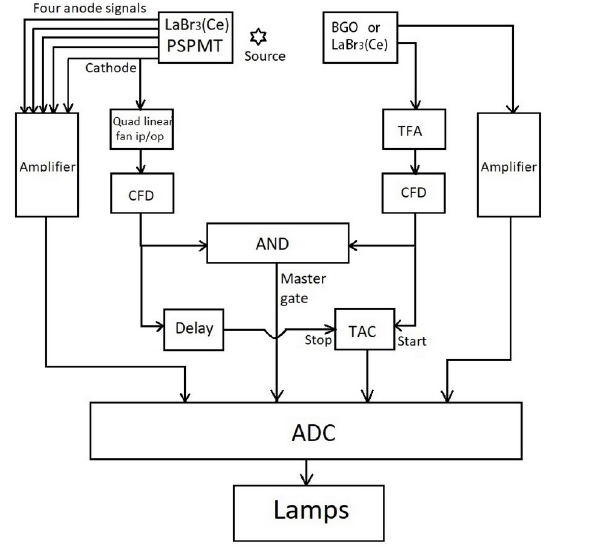
Fig. 2. Schematic diagram of the coincidence set-up, where a hexagonal BGO/ cylindrical LaBr 3 (Ce) is chosen as the complementary detector along with the position sensitive detector under